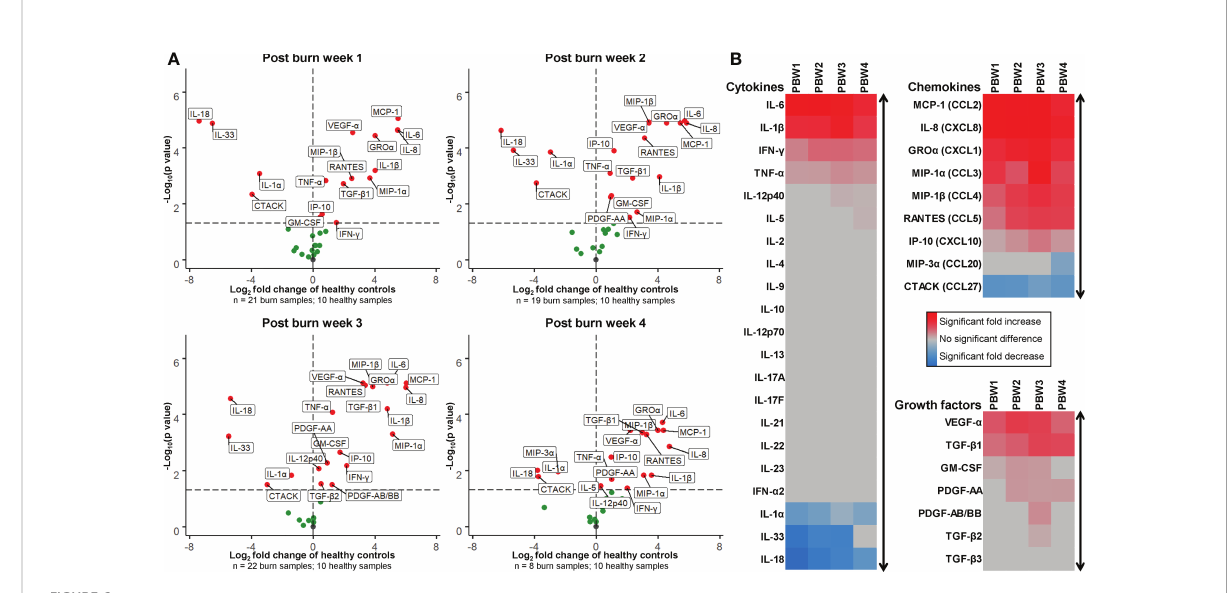
FIGURE 6 Expression of cytokines, chemokines and growth factors in burn tissue. (A) Volcano plot visualization of the expression of soluble factors in burn tissue from 1, 2, 3 and 4 weeks post burn injury. Dots represent soluble factors in burn tissue as Log 2 fold change as found in healthy skin controls. Factors with a statistically signi fi cantly different expression (p < 0.05) are labeled (values above the black striped line). (B) Heatmap visualization of fold increase/decrease of soluble factors in burn tissue compared to healthy skin, categorized by cytokines, chemokines and growth factors. P values were calculated using Mann-Whitney U statistical